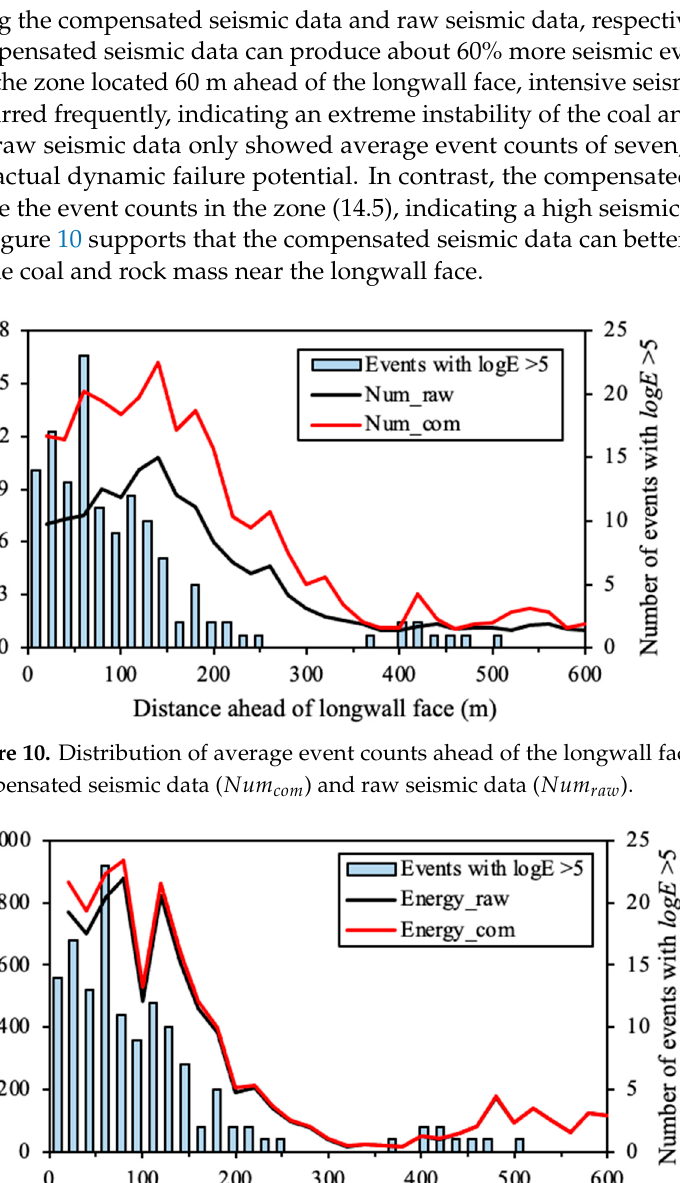
Figure 11. Distribution of average seismic energy ahead of the longwall face in LW250105 using compensated seismic data ( E com ) and raw seismic data ( E raw